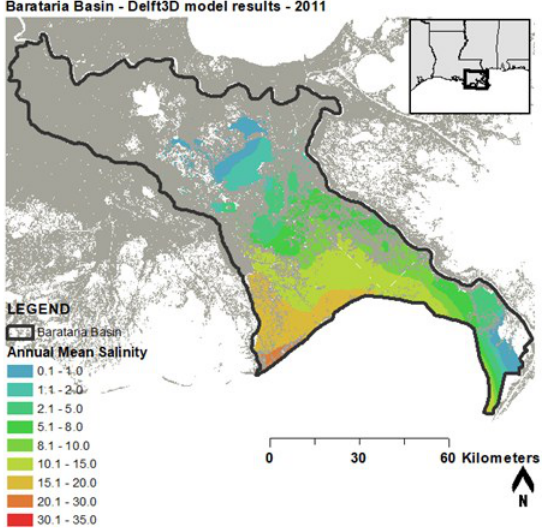
Figure 15. Annual mean salinity for 2011, a high river year, as modeled by Delft3D. Daily average model salinity animations and maps for the four model years (2011–2014) were generated and compared to the daily dolphin positions in order to understand the salinity conditions preferred by these marine mammals. The animations are provided as supplemental data to this report and are available online (see Supplementary Material section). A static map is shown as an example of this output in Figure 16. The blue contour lines represent the 8 ng/kg threshold, where daily mean salinity upstream of this contour is less than 8 ng/kg, and the locations downstream (e.g., Gulfward) have modeled daily mean salinity greater; the pink dots represent the dolphin locations. Unlike the earlier analyses of observational data, the duration of salinity values less than 8 ng/kg is not included in the Delft3D analysis; rather, the images produced are a snapshot in time and space of both model-predicted salinity concentration and observed dolphin